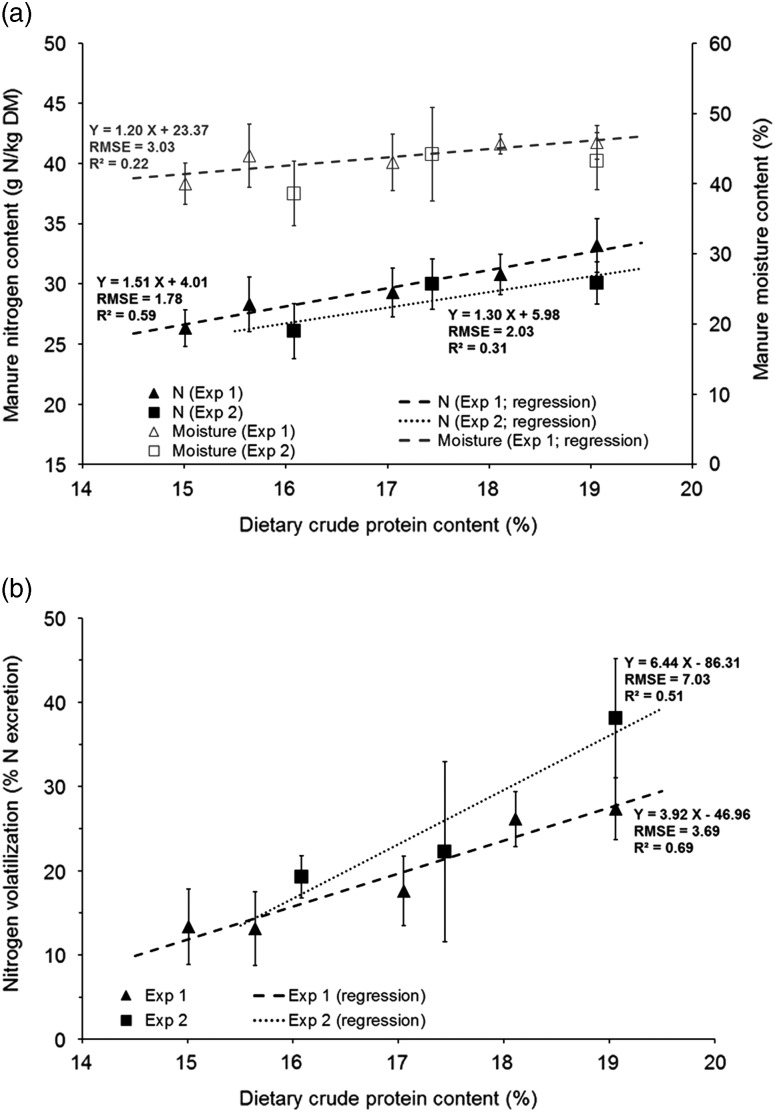
Manure composition and calculated nitrogen volatilization according to the dietary
CP content. Average (±SD) values of (a) nitrogen and moisture content of manure and
(b) total nitrogen volatilization (Nvol, equation (7)). Linear regressions were fitted
with pen values (n=4/treatment). For manure moisture in experiment
2, coefficients of the linear regression were not significantly different from
0.